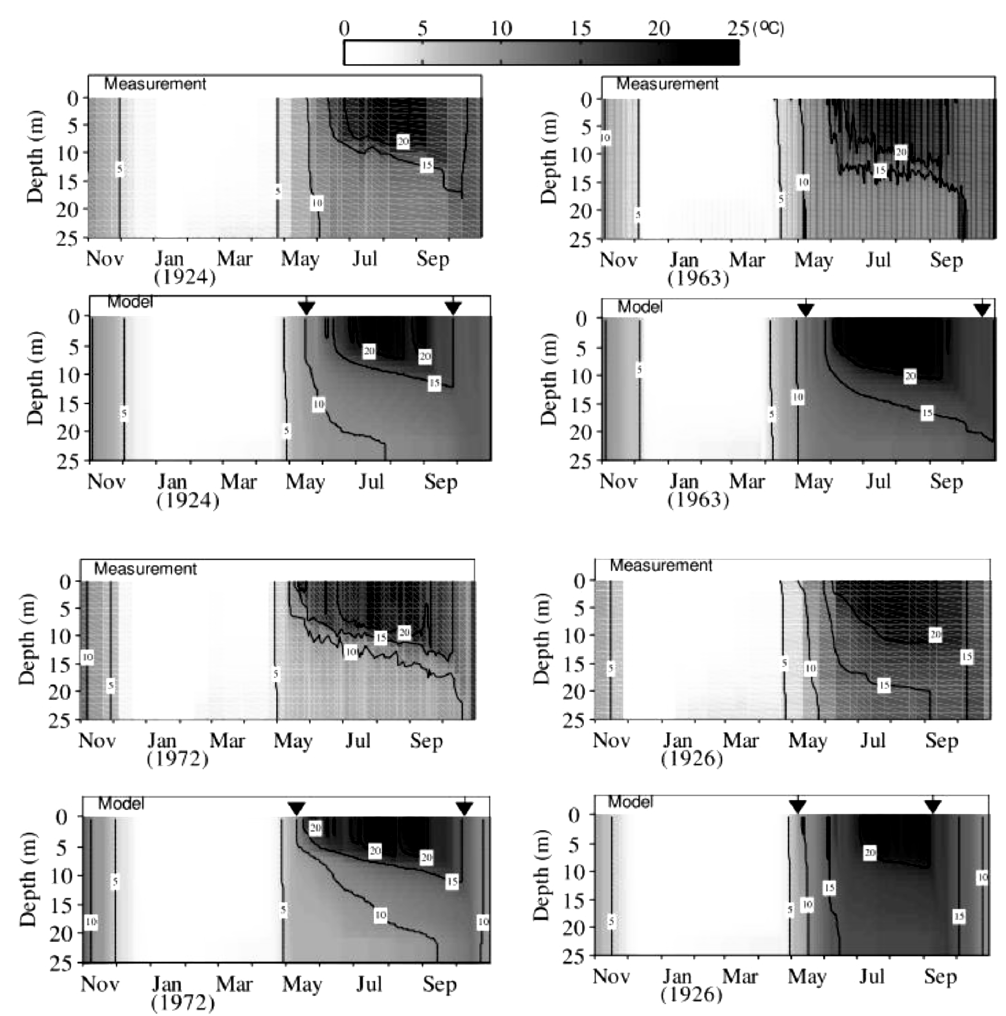
Figure 7. Comparison between the measured and simulated water temperatures as a function of time and depth under the cold epilimnetic year (1924), warm epilimnetic year (1963), cold hypolimnetic year (1972), and warm hypolimnetic year (1926) in Lake Mendota. Arrows mark the dates of onset of stratification and fall